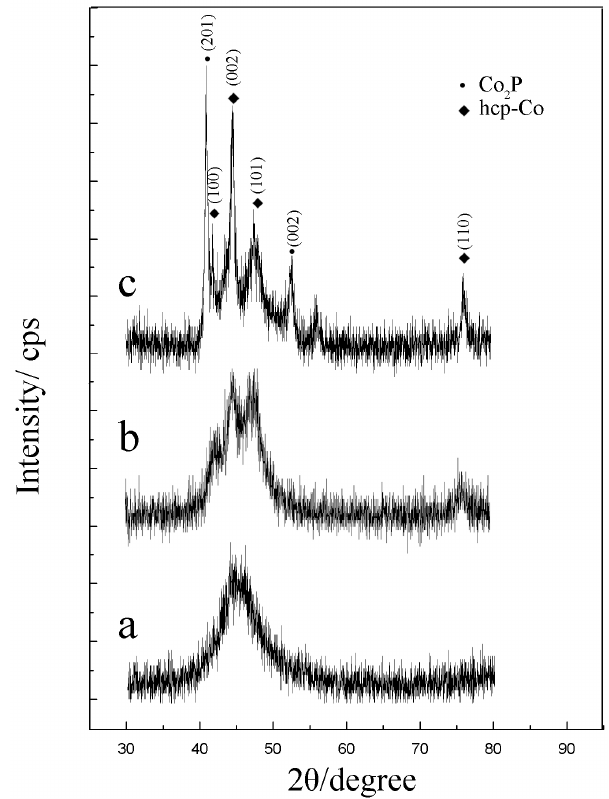
Figure 4. XRD patterns of coatings deposited under DP, heat treated under different temperatures: